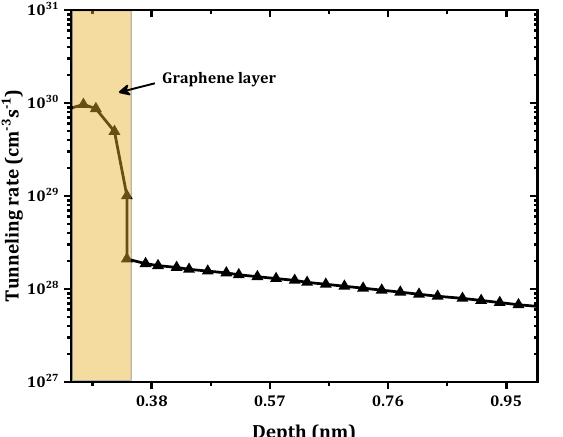
Figure 4. Variation in the tunneling rate when a graphene monolayer was inserted under 2 V of forward voltage.